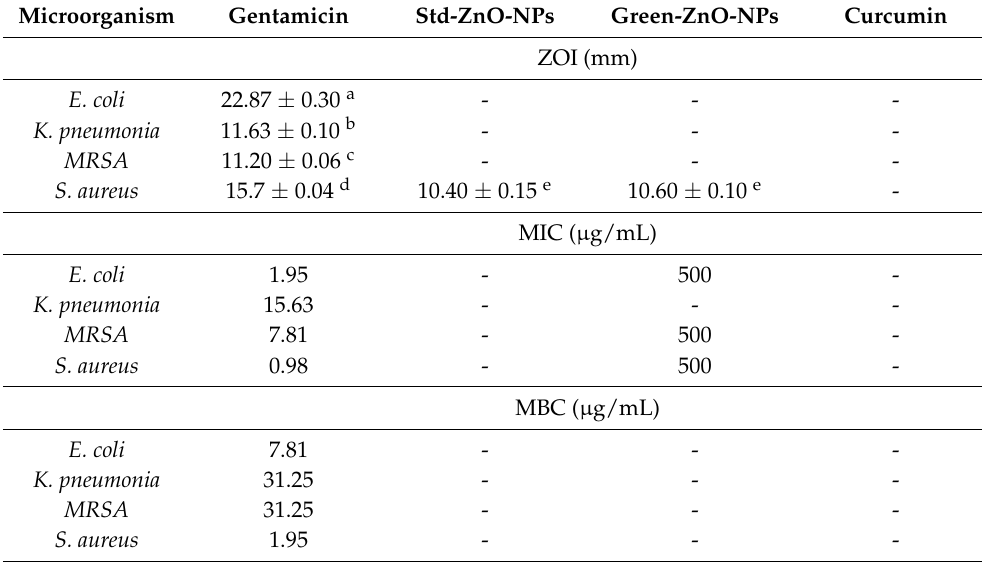
Table 2. Zone of inhibitions, minimum inhibitory concentration, and minimum bactericidal concen- tration of Std-ZnO-NPs, Green-ZnO-NPs, and curcumin against Gram-positive and Gram-negative bacteria. Tukey post hoc multiple comparison tests show a significant difference ( p < 0.05) between samples with different letters (mean ± SD; n =